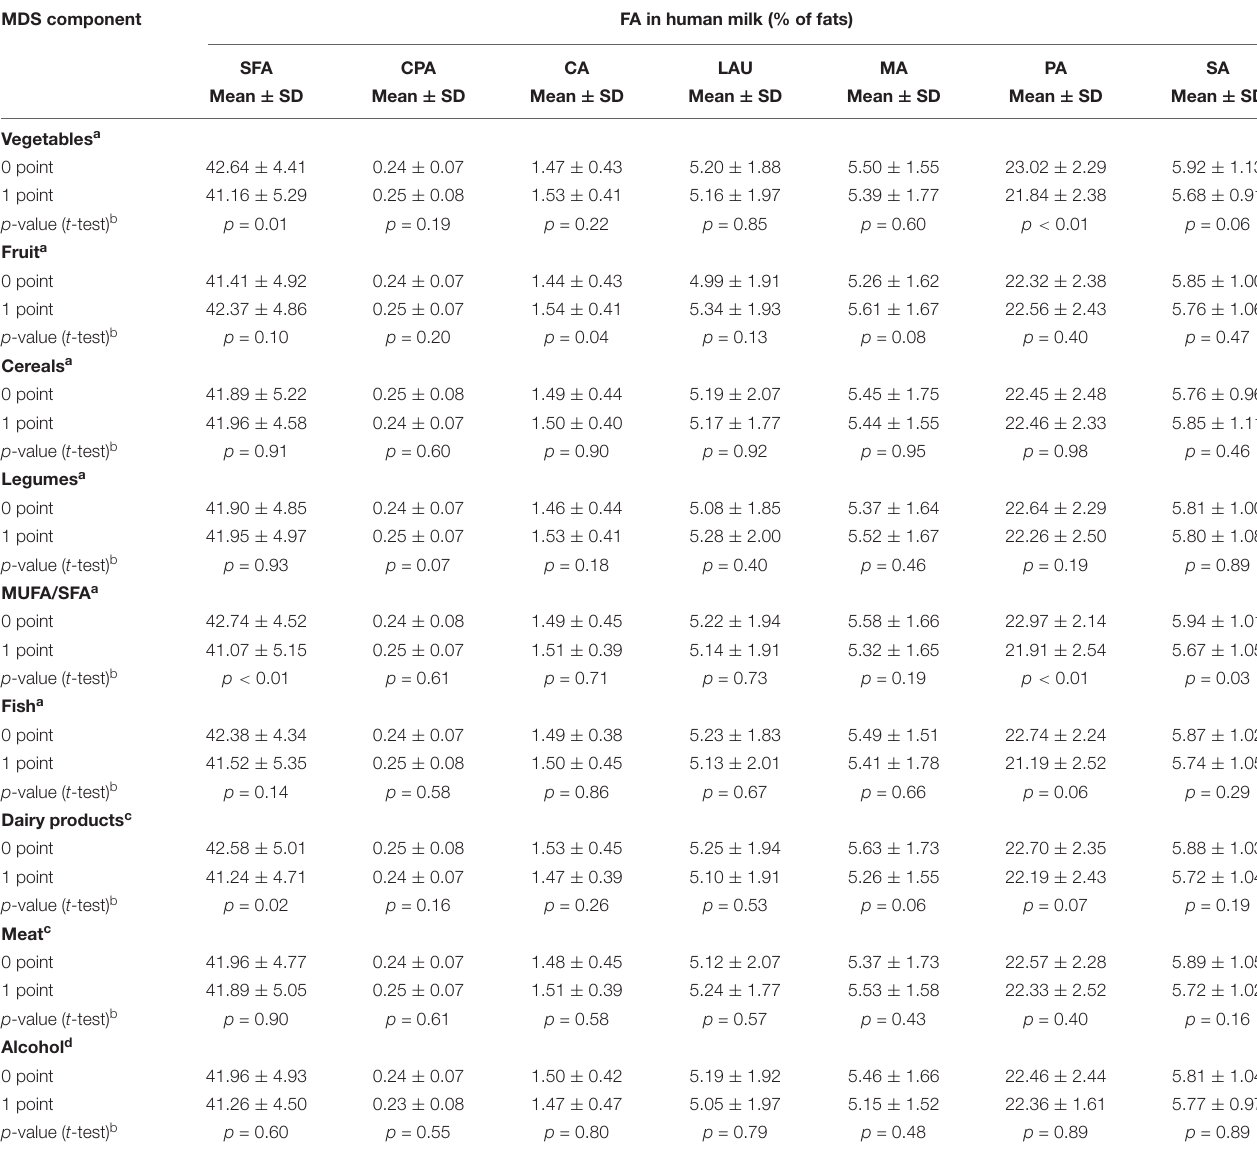
TABLE 4 | Mean and standard deviation contents of major saturated fatty acids in human milk (expressed as% of fats) according to the adherence of breastfeeding mothers to single components of the Mediterranean Diet Score. MDS component FA in human milk (% of